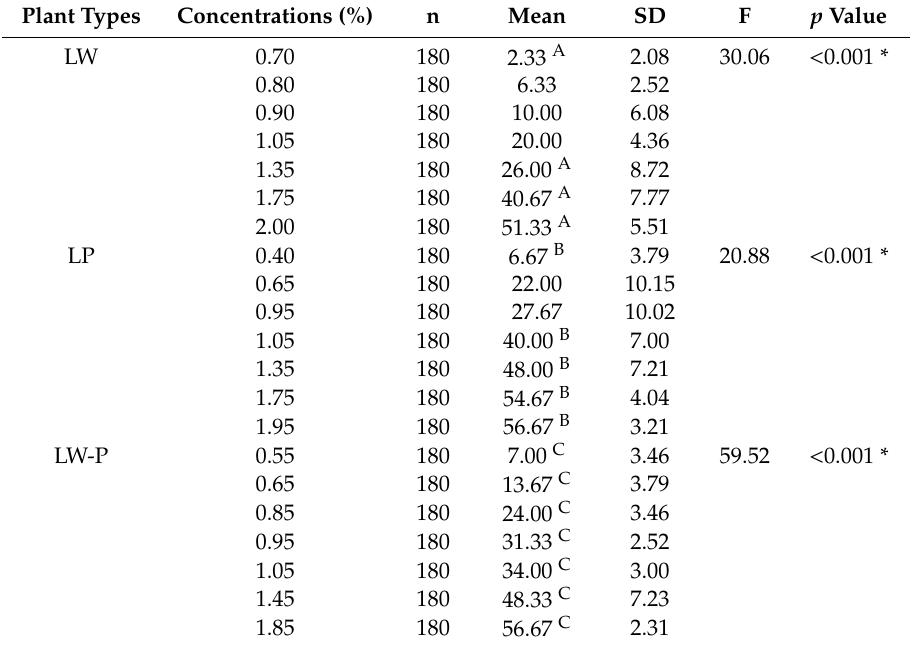
Table 2. Mean mortality rate of adulticidal activity of essential oils extracted from leaf parts of A. conyzoides with three colours against adult Ae. aegypti